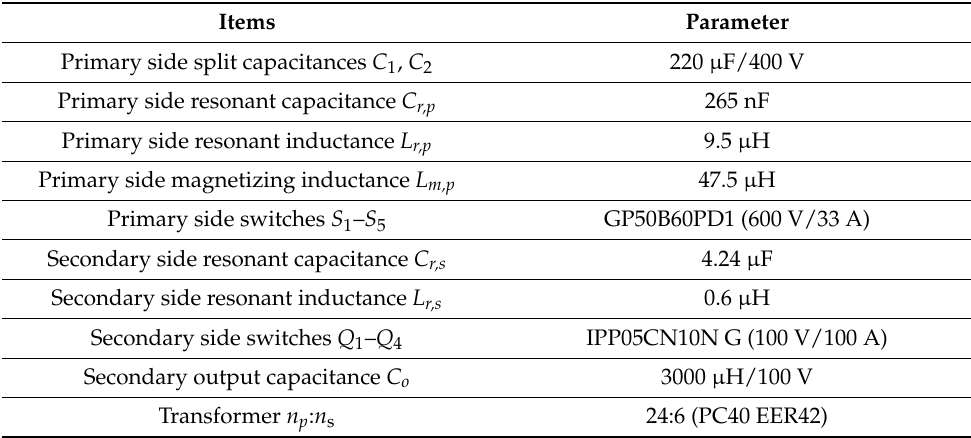
Table 2. Circuit Components in the laboratory